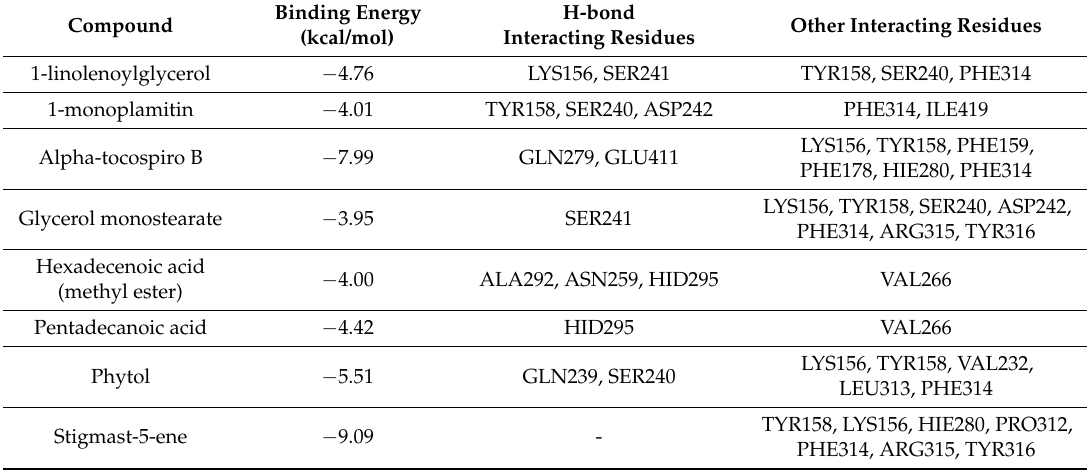
Table 6. Molecular interaction results of other tentative metabolites docked onto α -glucosidase